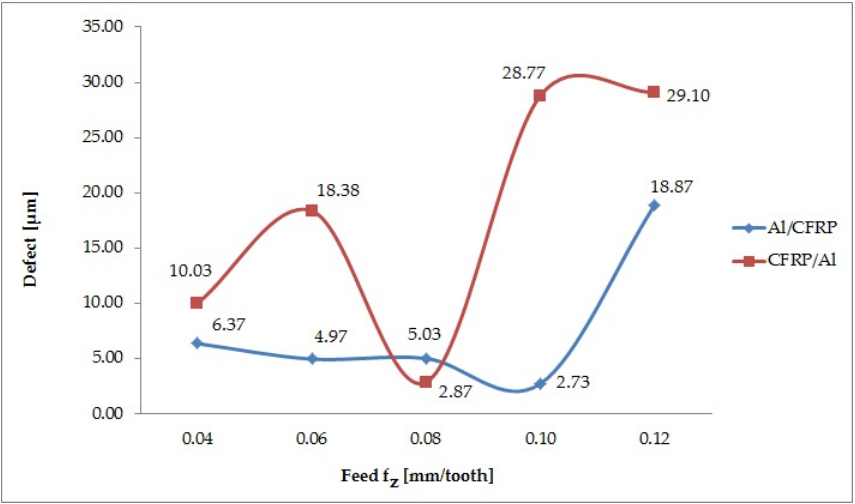
ff ect of feed change on value of defect. Figure 11. Effect of feed change on value of defect. Figure 11. E